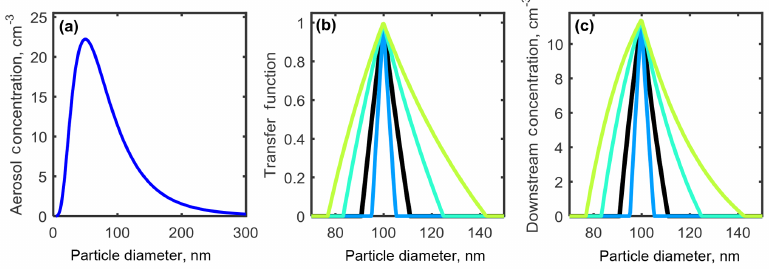
Figure 3. (a) A theoretical aerosol distribution generated using a lognormal function centered at 50nm. (b) The transfer function calculated using Eq. (7). (c) Multiplying the distribution by the transfer function gives the downstream aerosol concentration (cm − 3 ).